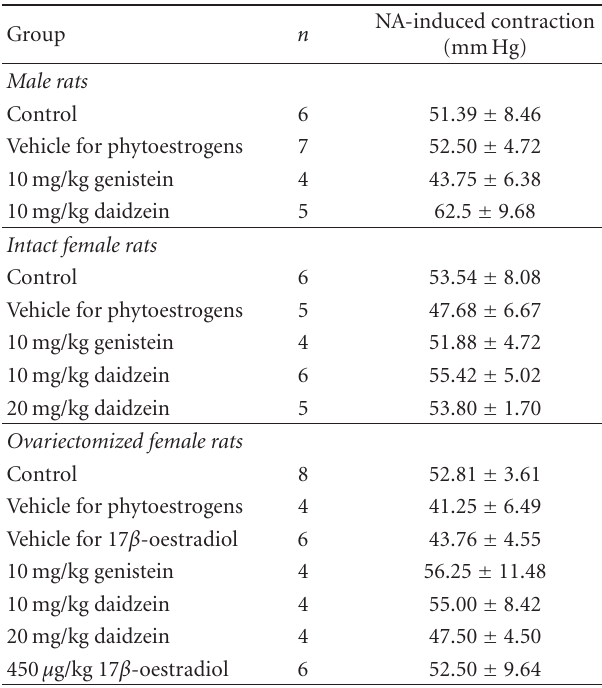
Table 1: Noradrenaline-induced